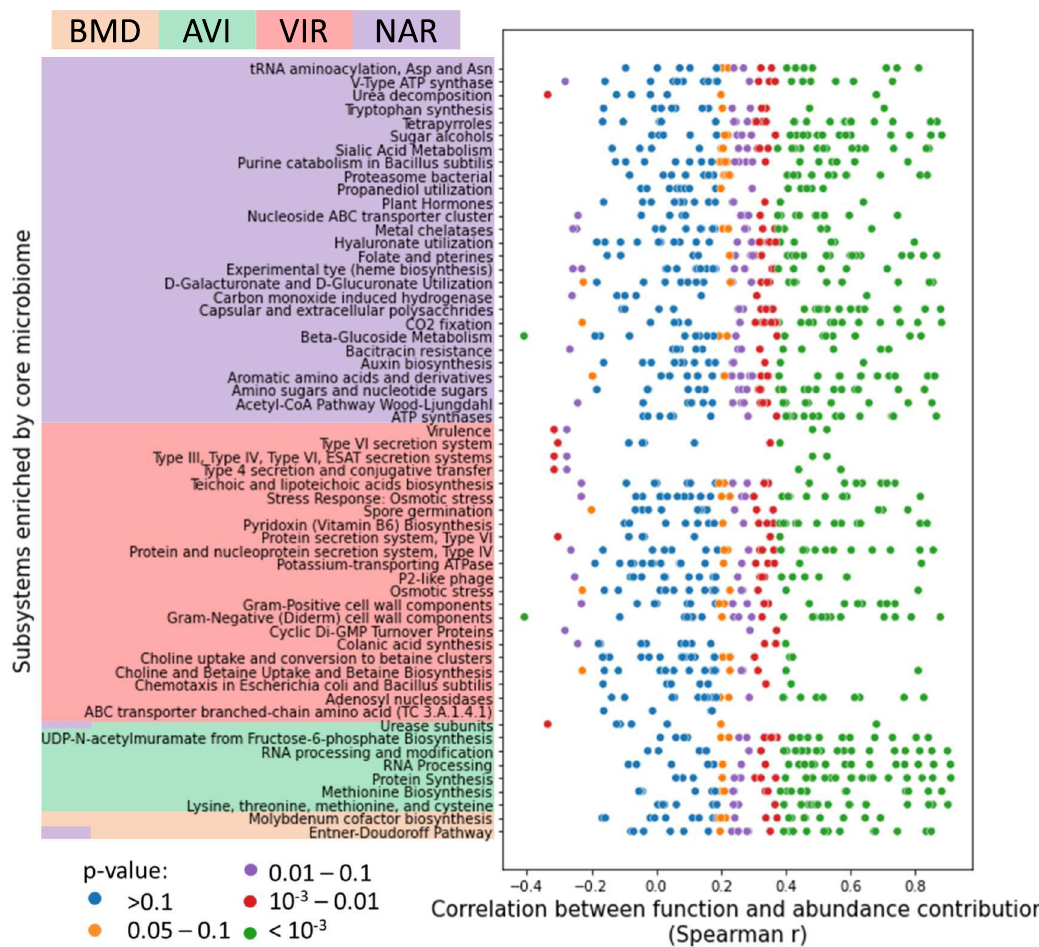
Fig. 3 Correlation between gene and relative abundance contributions of core genera. Rows in the fi gure indicate functional terms (subsystems) signi fi cantly enriched by different treatments when considering only genes assigned to core genera of the cecum microbiome. Each dot represents a core microbial genus and its corresponding value on the x-axis shows the spearman correlation between the relative abundance of the genus and its contribution to the abundance of the corresponding functional term across all samples ( n = 74 birds). The functional contribution is calculated as the mean copy number contributed by the genus across all the genes in the subsystem. Dot colors indicate the Spearman correlation p-value. BMD bacitracin methylene disalicylate, AVI avilamycin, VIR virginiamycin, NAR